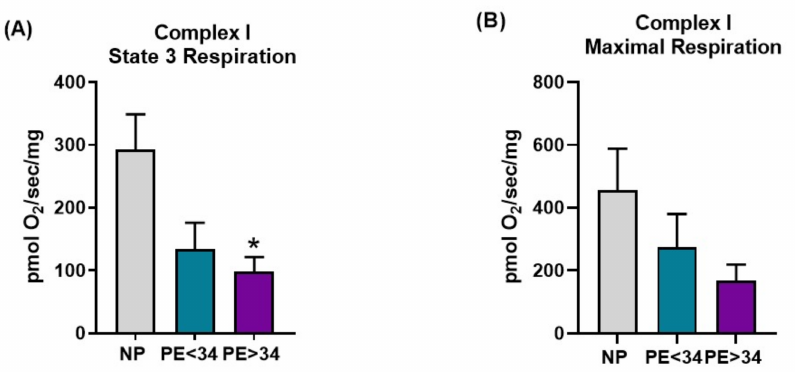
Figure 3. Complex I-mediated respiration in isolated mitochondria. Oxygraph-2K oxygen consump- tion assay showed Complex I placental mitochondrial state 3 respiration was significantly decreased in preeclamptic patients of late gestational age (PE > 34 weeks, n = 5; purple bar) and a trend towards reduction in preeclamptic patients of early gestational age (PE < 34 weeks, n = 4; teal bar) vs. normal pregnants (NP, n = 7; gray bar) ( A ). Further, placental mitochondrial maximal respiration showed a trend towards reduction in preeclamptic patients of both gestational ages (PE < 34 weeks, n = 4 and PE > 34 weeks, n = 5) vs. normal pregnants (NP, n = 7) ( B ). The results represent means ± SEM.